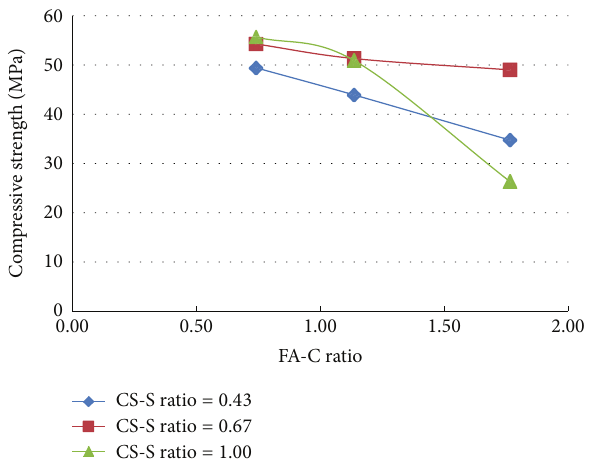
Figure 5: Compressive strength versus FA-C ratio (specimens S19– S27: with polypropylene fibres).